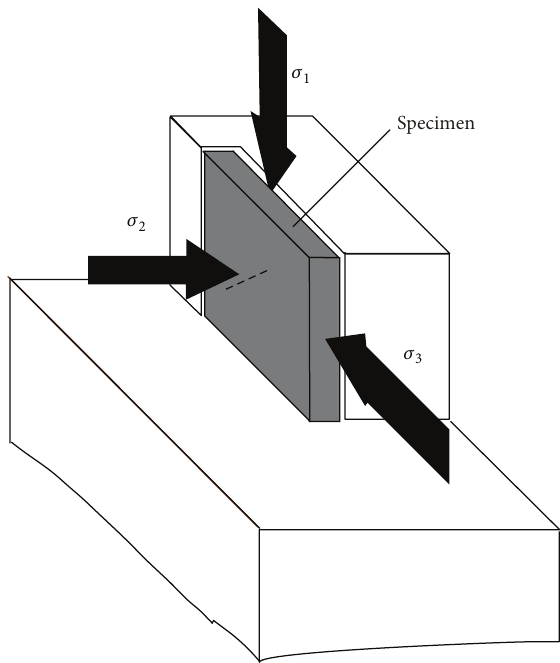
Figure 2: Sketch of a true triaxial loading device and the